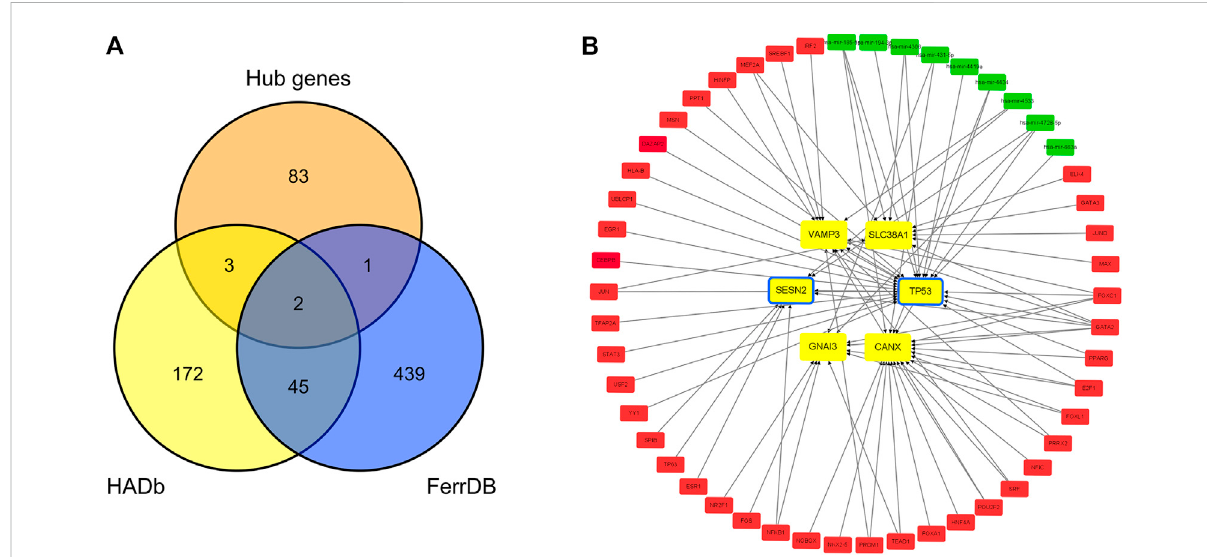
FIGURE 6 Autophagy-related and ferroptosis-related hub genes in IDD and associated TF-hub gene-miRNA network. (A) Autophagy- and ferroptosis- related hub genes in IDD, indicating that there are two genes simultaneously associated with both autophagy and ferroptosis. (B) Red rectangles represent TFs, green rectangles represent miRNAs, yellow and blue rectangles represent autophagy and ferroptosis genes, respectively, and yellow rectangles with a blue frame represent genes associated with both autophagy and